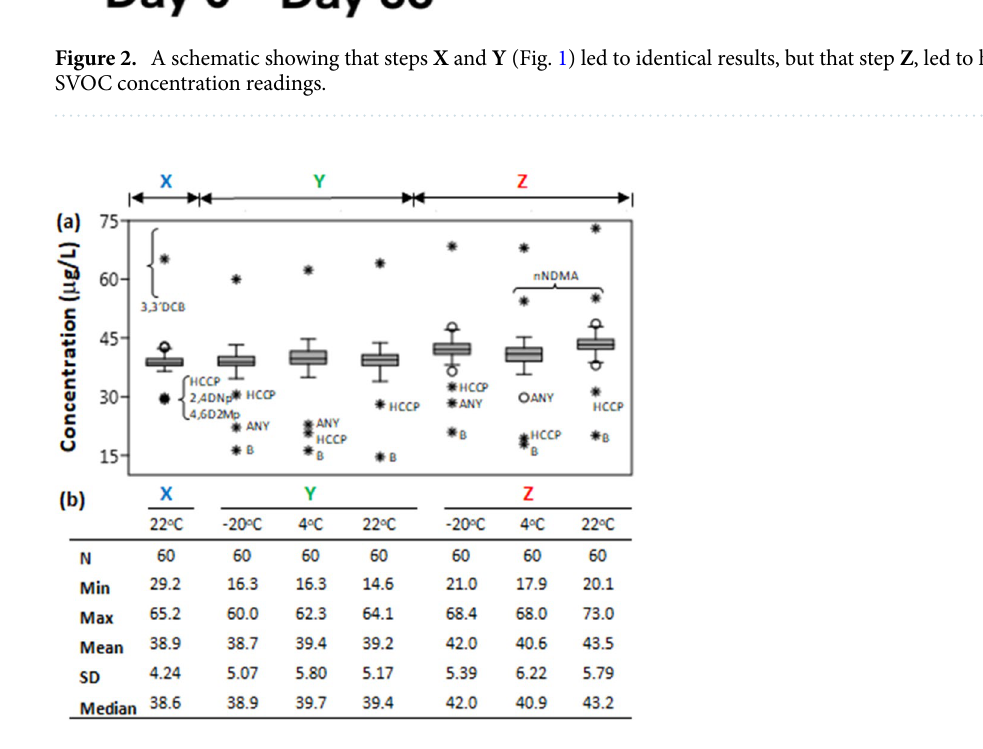
Figure 3. ( a ) Boxplots showing the distribution of the recoveries of the 60 SVOCs used in this study (Online Resources 1) as a function of temperature. Abbreviations have the following meanings: 3,3DCB: 3,3 ′ -dichlorobenzidine; ANY: acenaphthylene; B: benzidine; HCCP: hexachlorocyclopentadiene; nNDMA: N-nitrosodimethylamine. ( b ) Summary statistics associated with the distribution are color coded as in Fig. 1 and aligned vertically below the corresponding boxplots. SVOCs were spiked at 40 μg/mL (benzidine and 3,3 ′ -dichlorobenzidine at 80